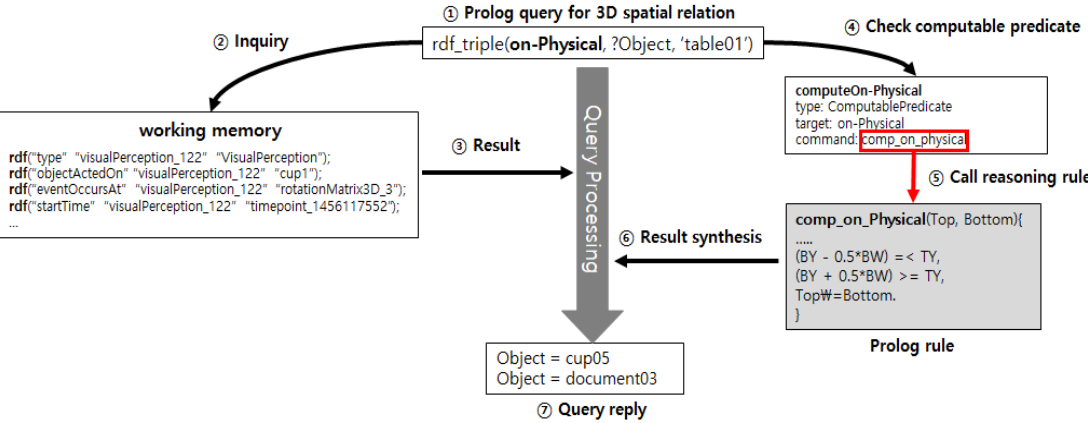
Figure 5. Translating context knowledge in the form of RDF/OWL to Prolog facts.